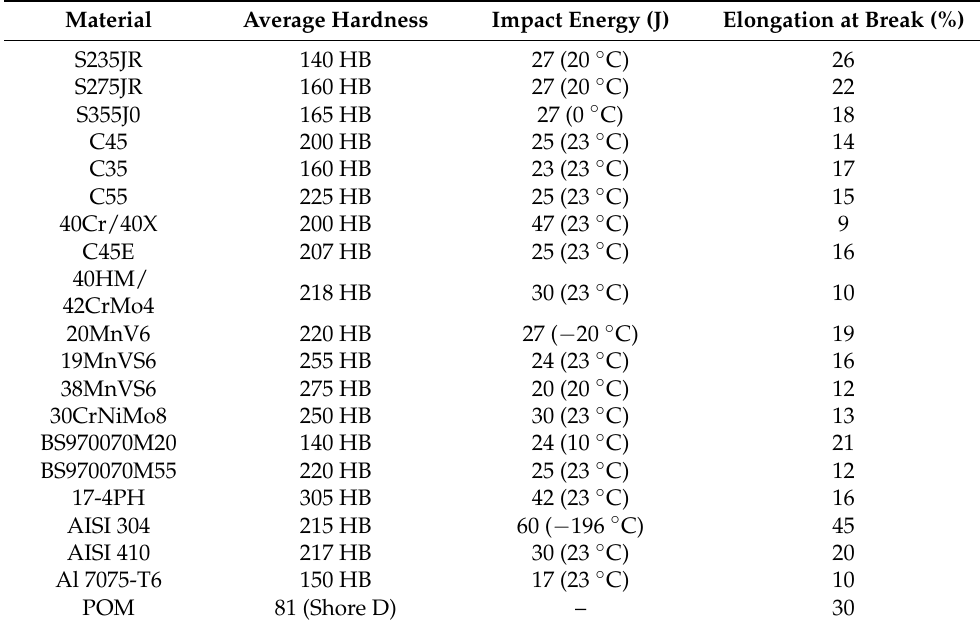
Table 6. Additional properties of the materials used for piston